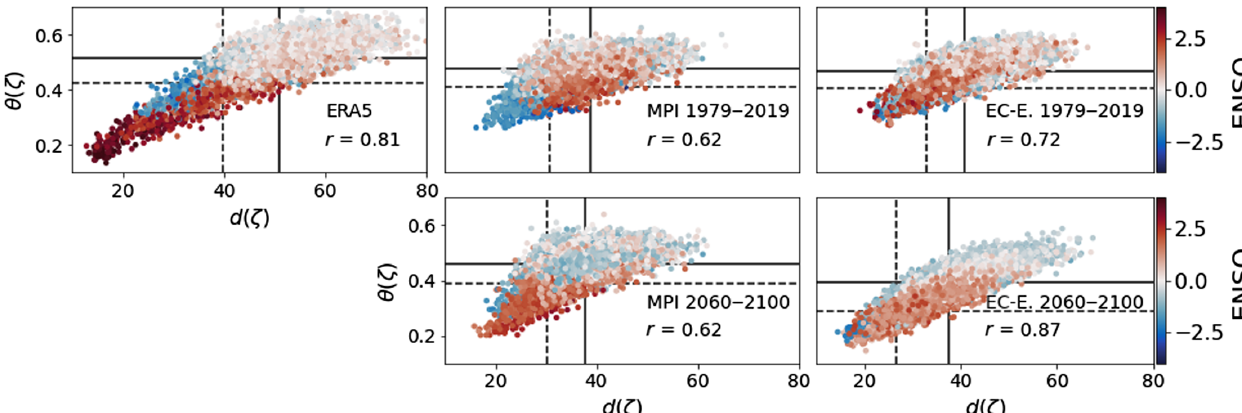
FIG. 5. (a) Scatter plot of stability θ ð ζ Þ and local dimension d ð ζ Þ for observations (ERA5) and the two models (MPI and EC-Earth). Each point represents a day in the period 1979 – 2019 (top panels) or 2060 – 2100 (bottom panels). Each point is colored according to its value in the first (standardized) Isomap component, quantifying here the ENSO index and dashed (solid) lines indicate the 0.1 (0.5) quantiles of d ð ζ Þ and θ ð ζ Þ . The correlation r between each d and θ is also reported. The computation spans the full 17 092-dimensional state